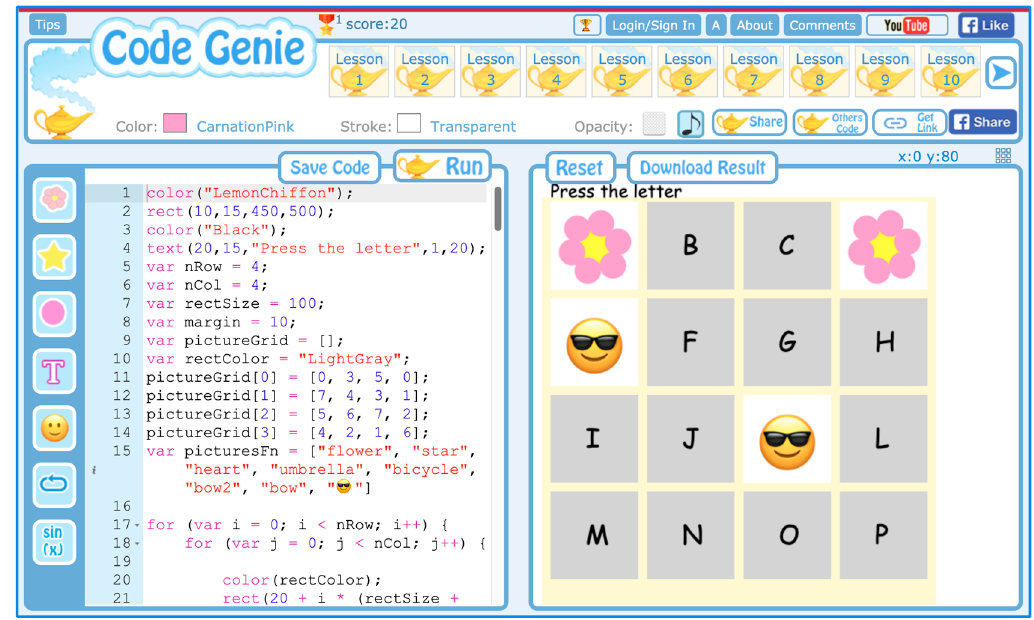
Figure 6. Matching the picture game in the Code Genie Web IDE.